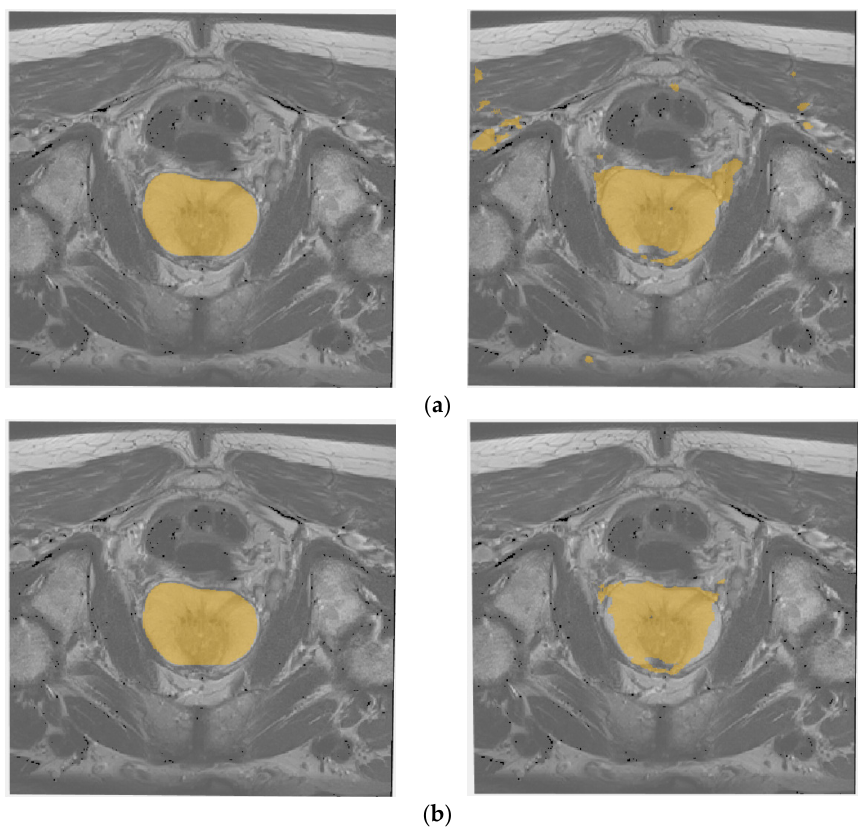
Figure 10. Visual comparison of prostate gland detection based on: ( a ) 3D U ‐ Net (3), and ( b ) 3D AID ‐ U ‐ Net (2, 1). The slice images shown in the left column are the original CT ‐ Scan slices accompanying with the pixel ‐ wise annotations for prostate gland.